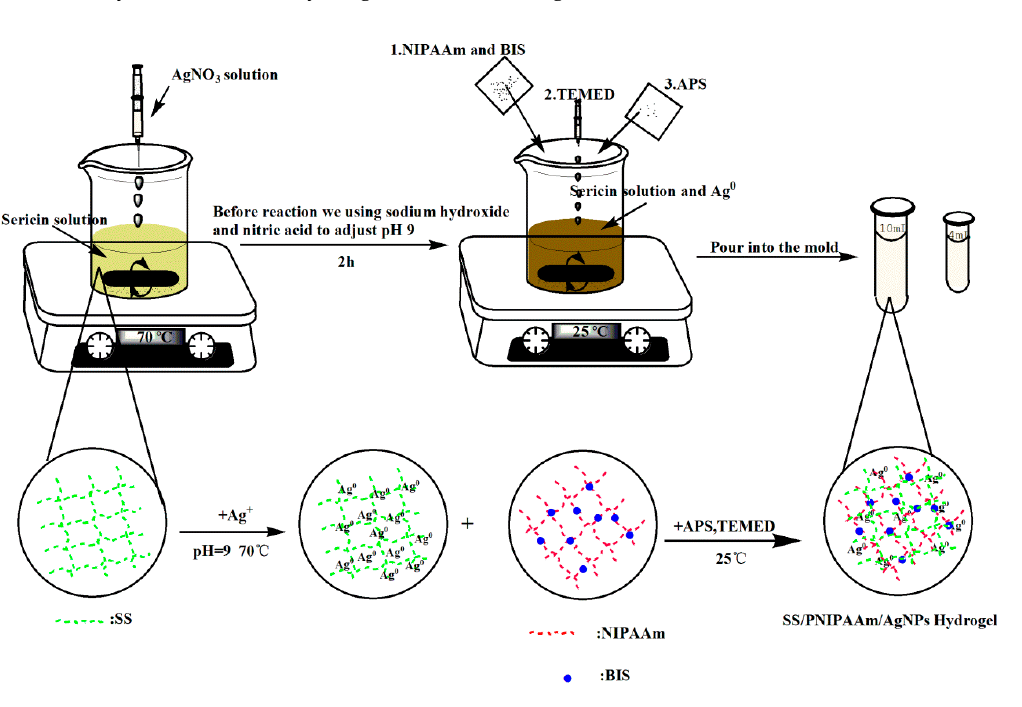
Figure 1. Synthesis scheme of the IPN hydrogel.